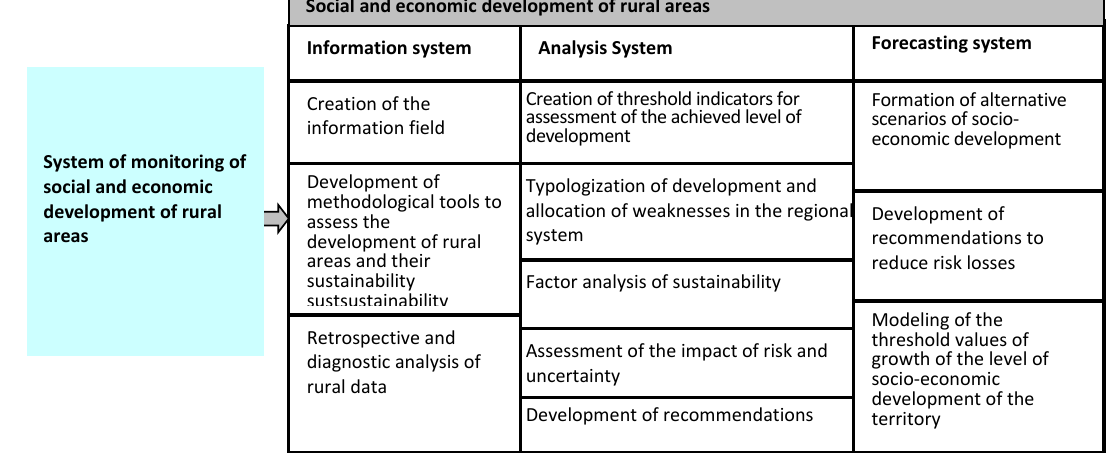
Fig . 3: Conceptual model of formation of the system of monitoring of social and economic development of rural areas